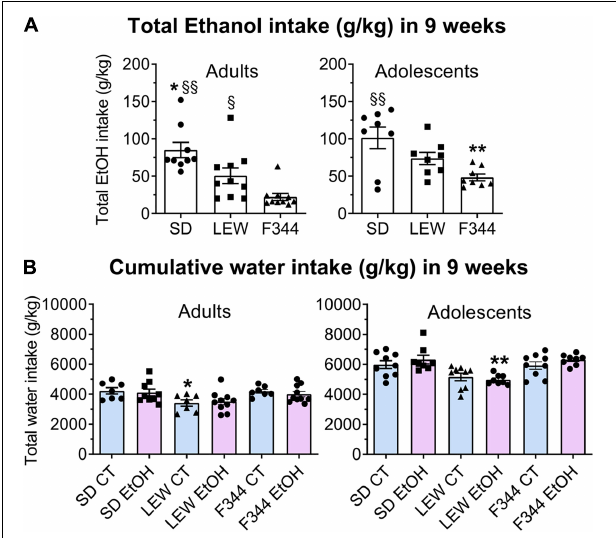
FIGURE 4 | Alcohol preference expressed as percentage of total fluid intake in adult and adolescent groups of the three strains. Data are expressed as means ± SEM. * p < 0.05 vs. preference in the first week within each strain; § p < 0.05 vs. corresponding value in the Fischer 344 (F344) strain; # p < 0.05 vs. the corresponding value in the adolescent group of the same strain by two-way ANOVA for repeated measures followed by Tukey’s post hoc test.